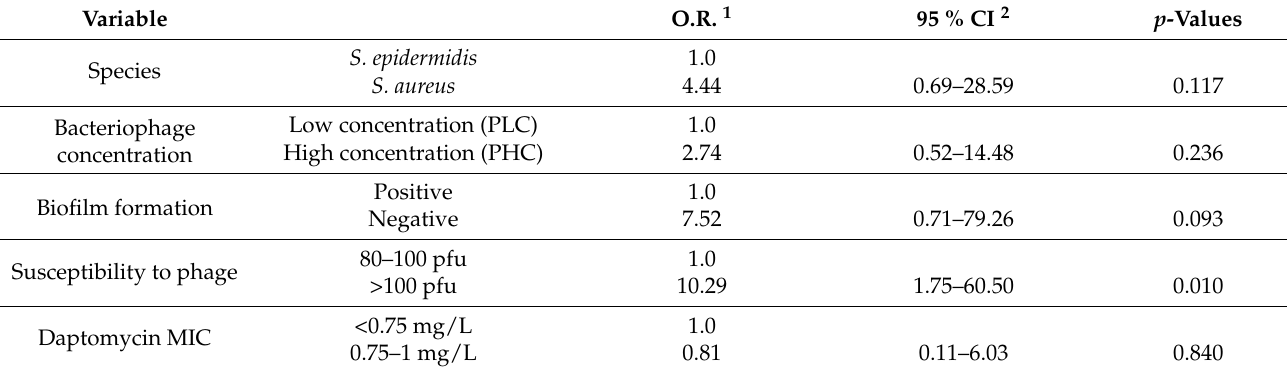
Table 2. Associations of growth inhibition caused by bacteriophage with features of staphylococci.